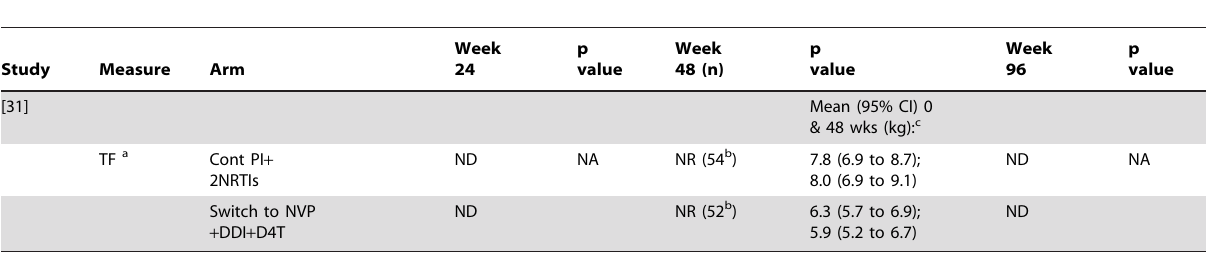
Table 23. Switching studies: change from baseline in trunk fat (TF) on DEXA scan: PI versus NNRTI.